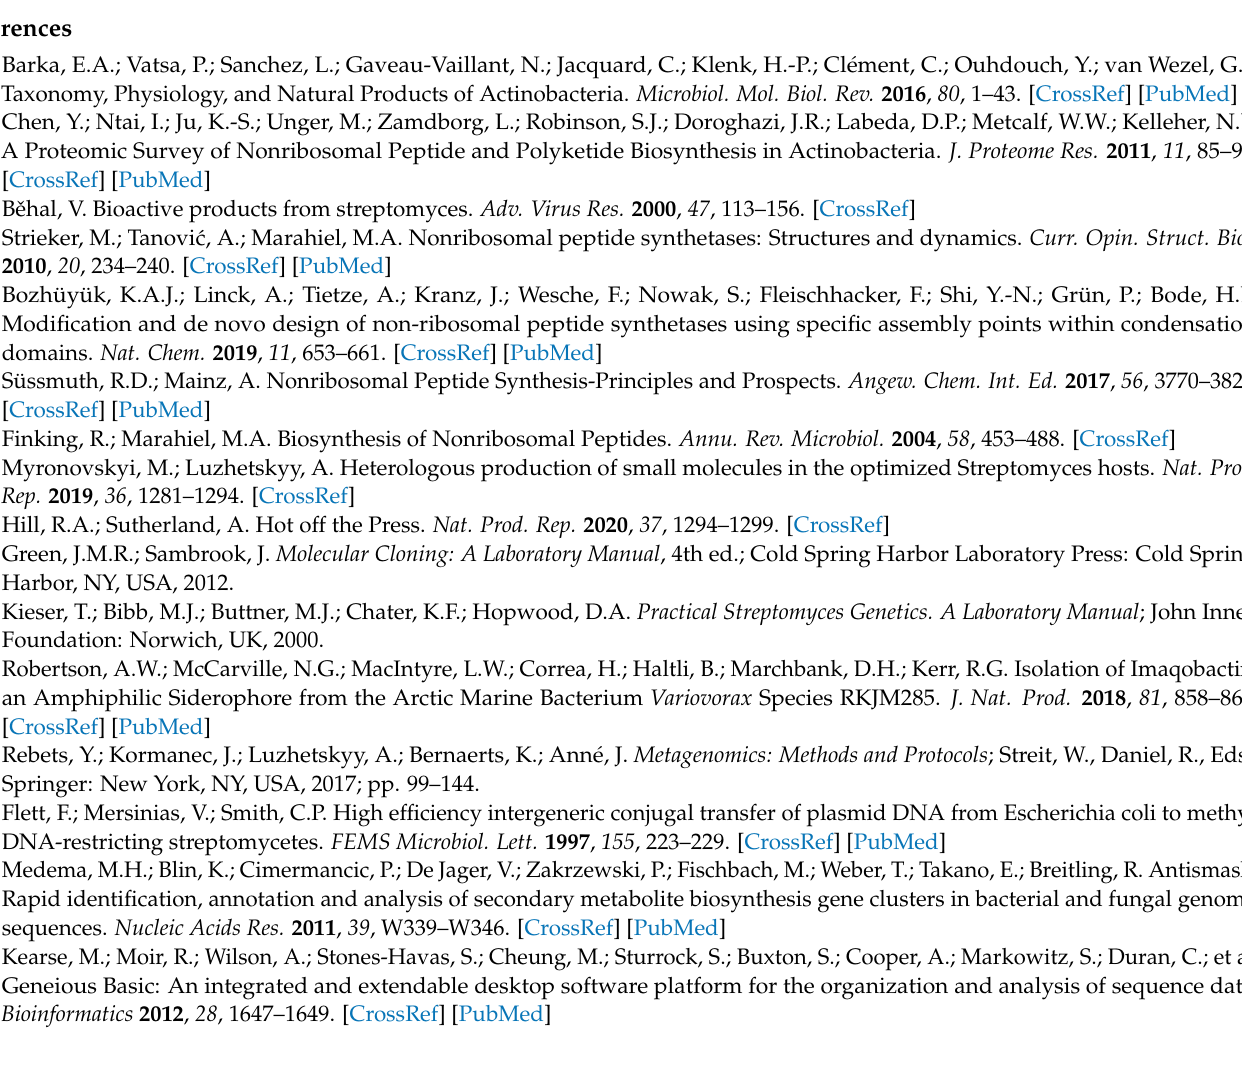
D, Figure S44: MS/MS spectra of depsibosamycin N, Figure S45: MS/MS spectra of depsibosamycin O, Figure S46: TE domain alignment of the depsibosamycin cluster (Query) and the bosamycin cluster (Sbjct), Figure S47: LC-MS chromatograms of S. lividans I7 with the dbm gene cluster, Table S1: Strains, BACs, plasmids, and primers used in this work, Table S2: NMR data for depsibosamycin C, Table S3: NMR data for bosamycin B, Table S4: NMR data for bosamycin C, Table S5: NMR data for bosamycin